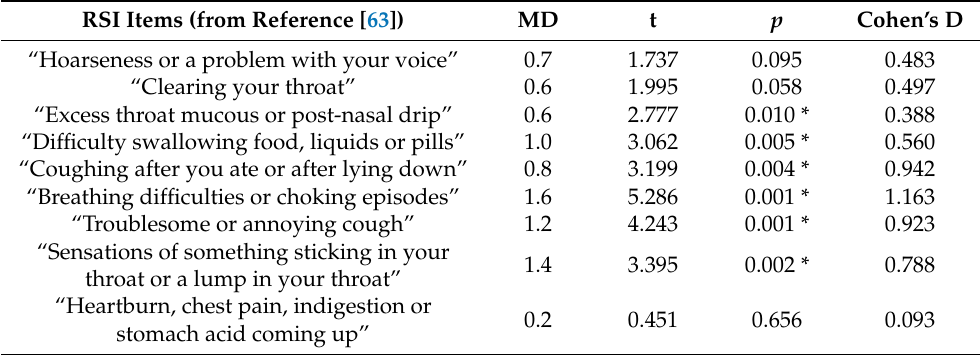
Table 8. Results of paired t test and effect size for RSI items ( n = 25). All items were quoted verbatim from the original RSI scale by Belafsky et al. [63]. Cohen’s d: small = 0.2; medium = 0.5;